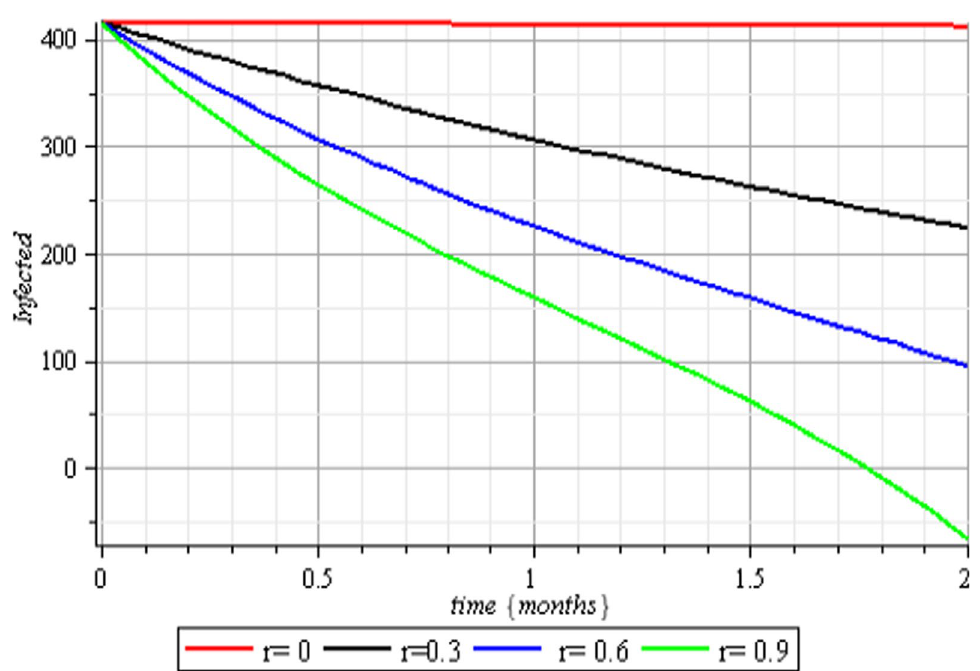
Fig. 5 Therapeutic effects on the infected